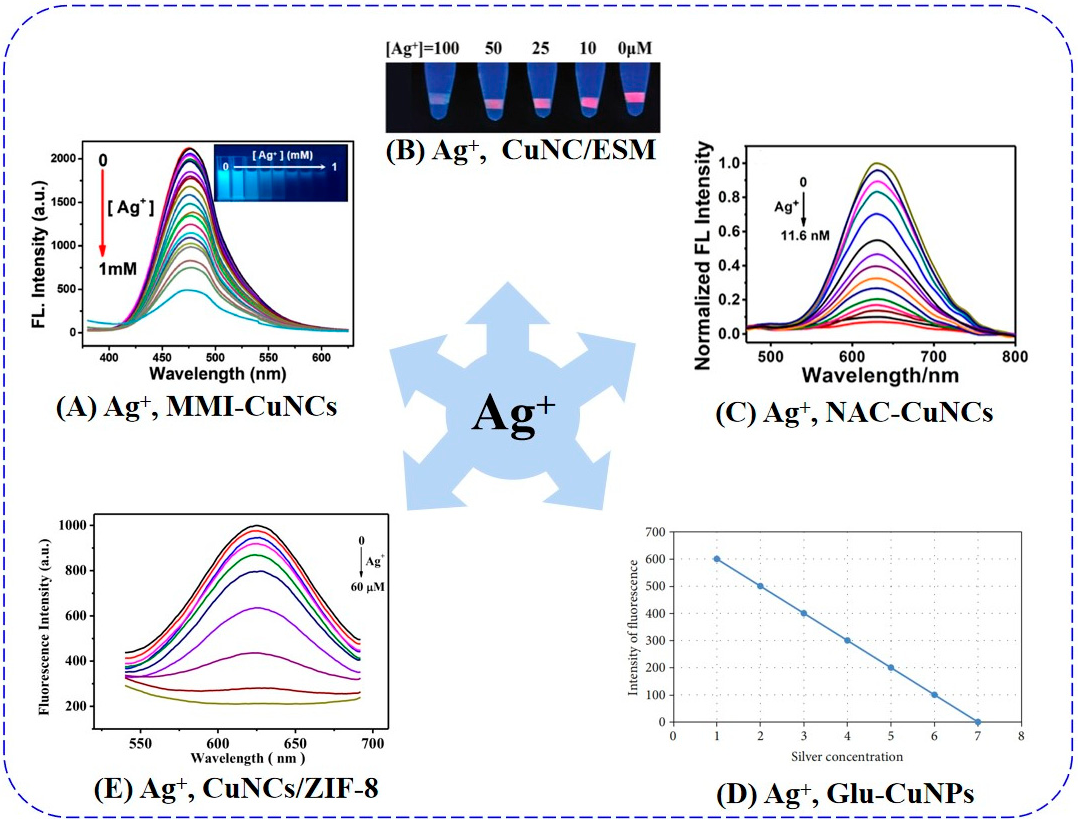
Figure 8. CuNCs for Ag + detection. ( A ) Fluorescence emission spectra in the presence of Ag + using MMI-CuNCs as a probe. Inset: the photo of MMI-CuNCs under a UV lamp [53], Copyrights from American Chemistry Society, 2022. ( B ) The photo of CuNC/ESM in the presence of Ag + from 0 to 100 μ M under a UV lamp [56], Copyrights from Springer, 2019. Fluorescence spectra of different concentrations of Ag + injected into ( C ) NAC-CuNCs [84], Copyrights from Elsevier, 2022. and ( E ) CuNCs/ZIF-8 [86], Copyrights from Elsevier, 2022. ( D ) The relationship between Glu-CuNPs absorption spectra and Ag + concentration [85], Copyrights from Hindawi, 2022.